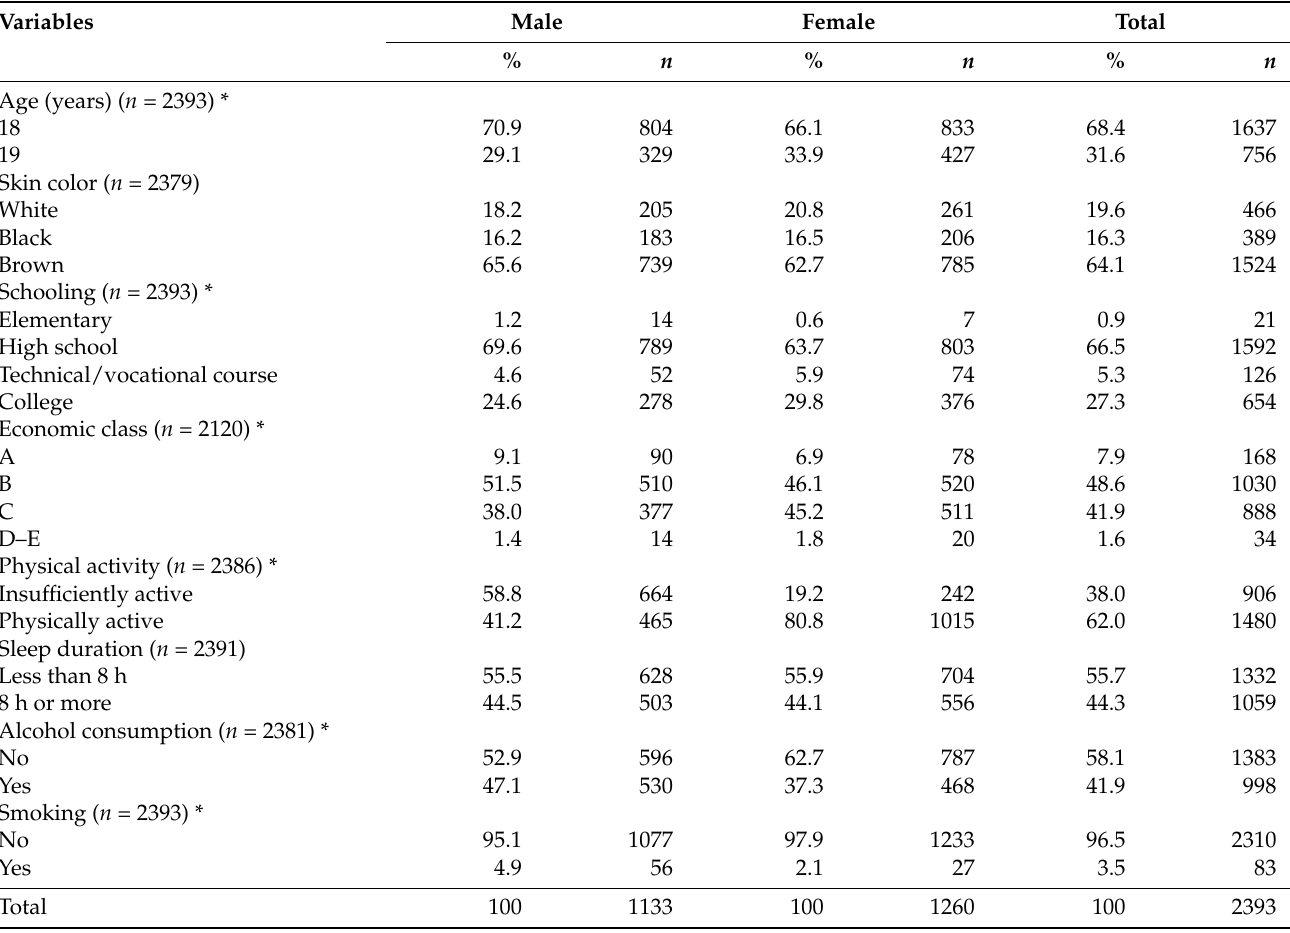
Table 1. Sociodemographic characteristics and lifestyle habits of adolescents according to sex. Sao Luis, Brazil, 2016.